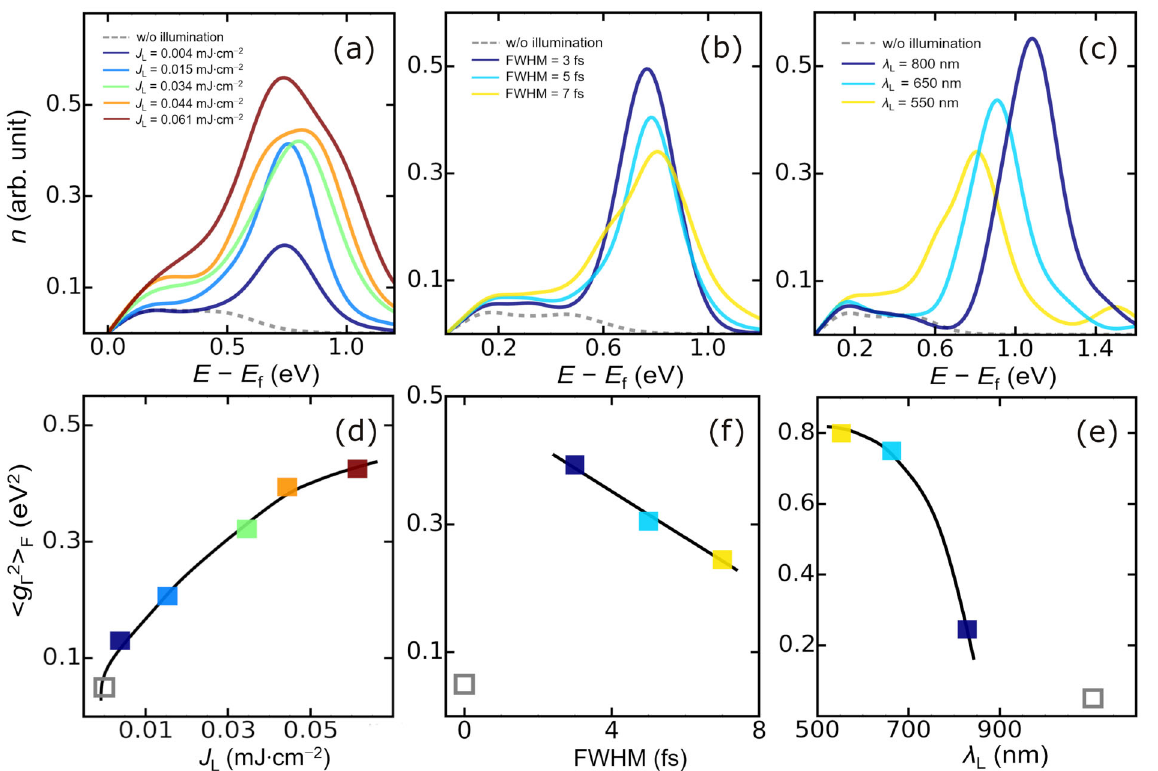
Fig. 4 The carrier distribution and EPC under different conditions. The photoexcited carrier distribution on π * band under ( a ) different pump fl uence J L ( λ L = 800 nm, FWHM ~7 fs), ( b ) FWHM ( λ L = 800 nm, J L ~ 0.035 mJ/cm 2 ), and ( c ) wavelength λ L (FWHM ~7 fs, J L ~0.035 mJ/cm 2 ) (cid:1) (cid:3) in undoped graphene. The effective EPC matrix elements g 2 Γ